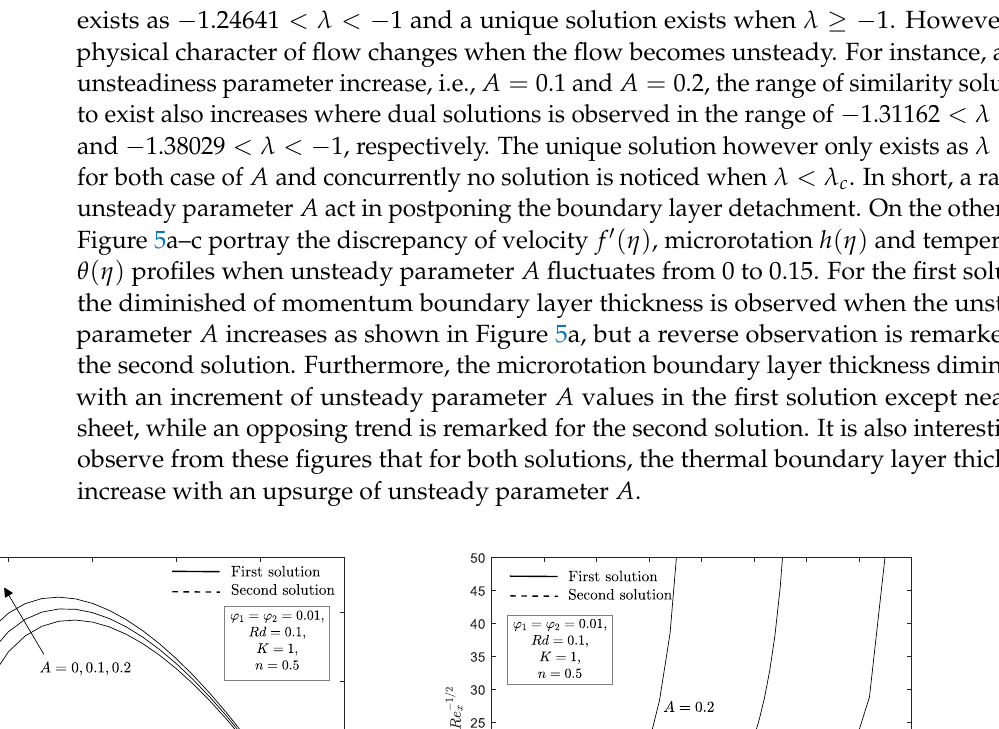
1/2 x ; ( b ) Nu x Re